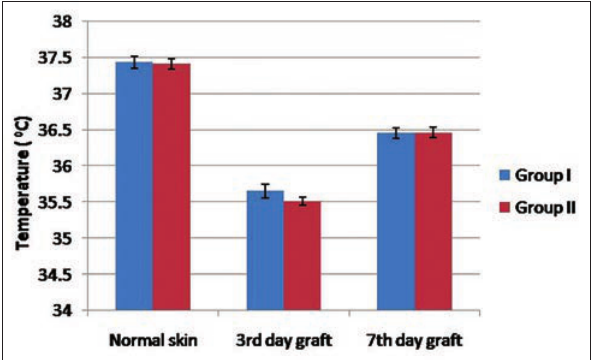
Figure-6: Mean ± standard error temperature (°C) of the graft and adjoining skin in different groups at different time intervals.